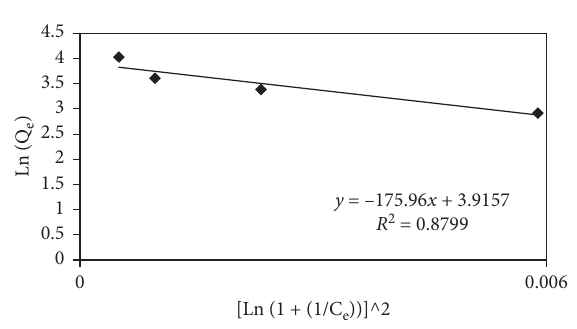
Figure 17: Linearity of D - R model.